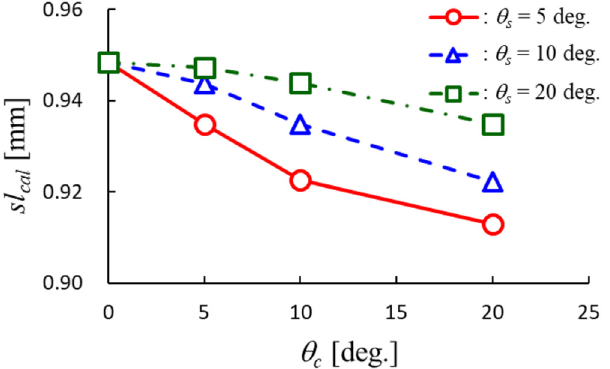
Fig. 15. In fl uence of u s and u c on t ave